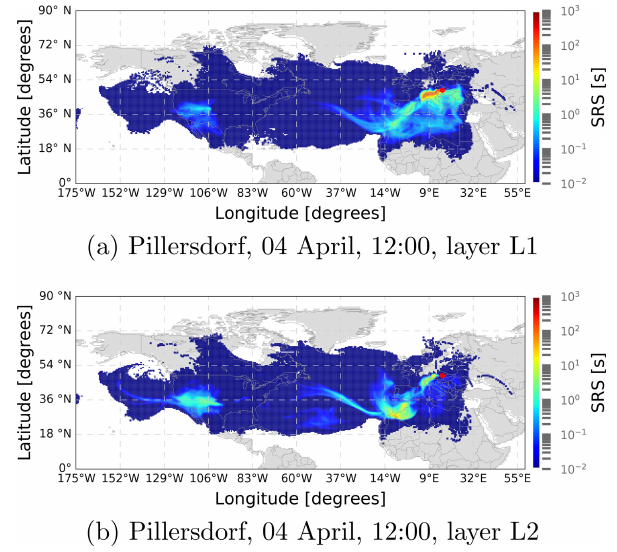
Figure 15. Source–receptor sensitivity for layers L1 (a) and L2 (b) , Pillersdorf, 4 April, 12:00.